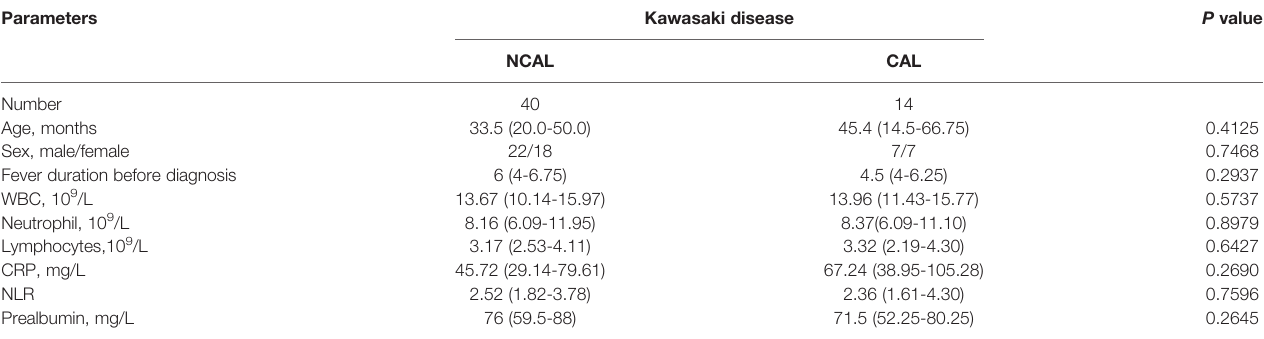
TABLE 2 | Characteristics of patients with KD classi fi ed according to coronary artery lesions or not. Parameters